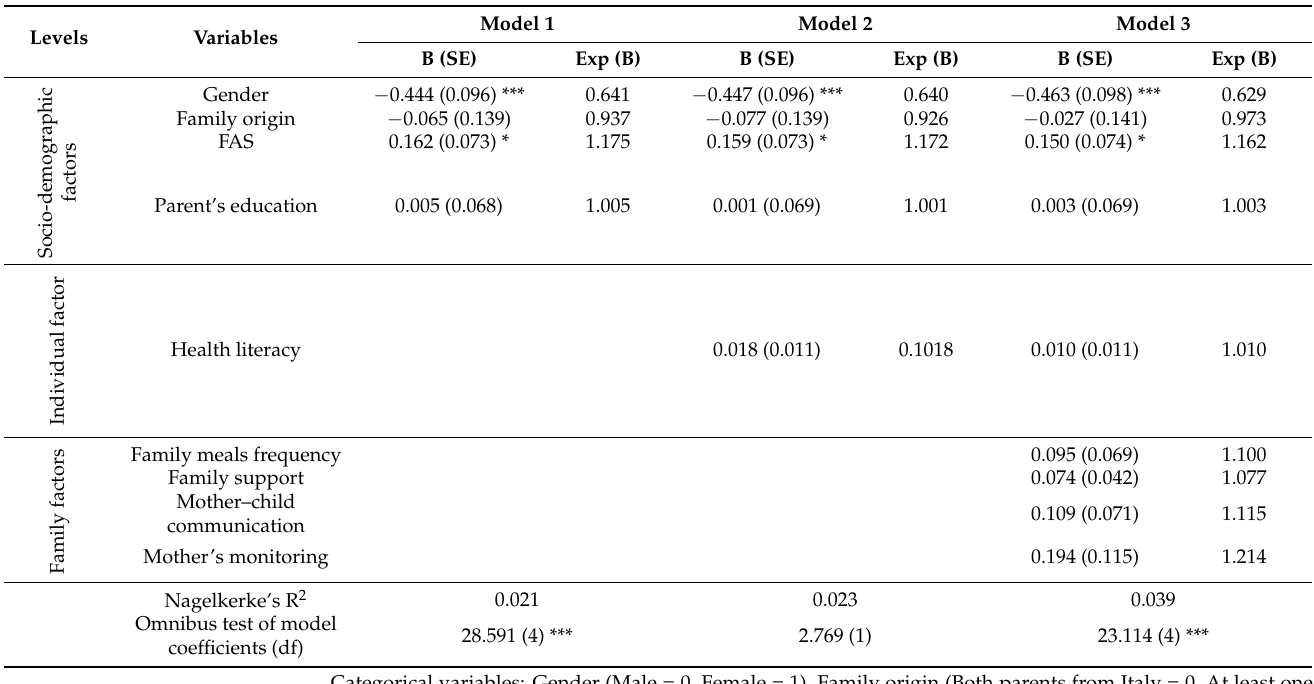
Table 7. Results of multiple binary logistic regression models predicting breakfast